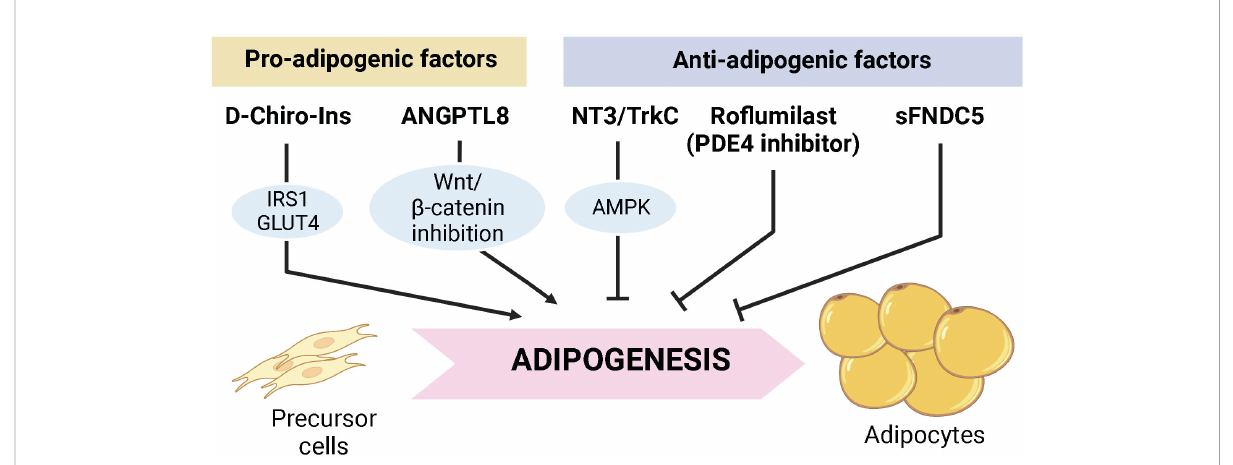
FIGURE 1 Proposed factors modulating adipogenesis in this research topic. D-Chiro-Ins and ANGPTL8 are suggested to stimulate adipocyte differentiation and lipid deposition. On the other hand, NT3/Trtk3 axis, Ro fl umilast, and recombinant sFNDC5 are suggested to suppress adipogenesis with increased lipolysis, which might potentially lead to reduced adipose tissue